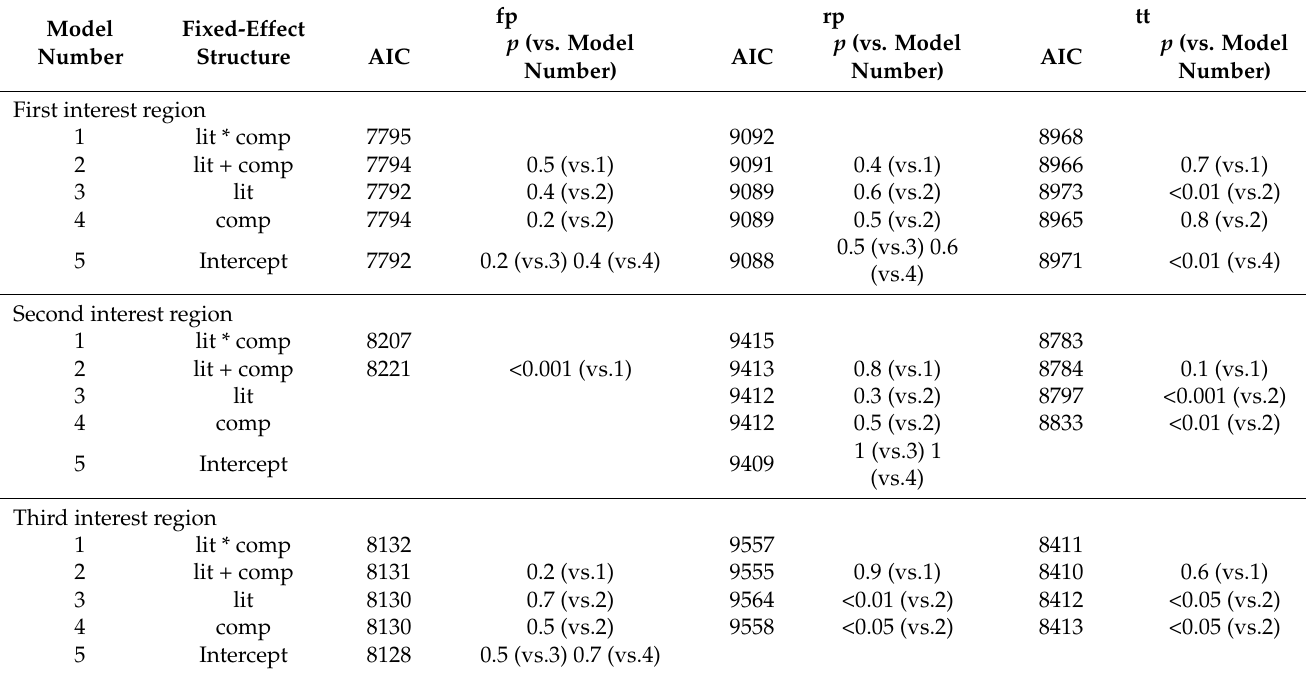
Table 2. Series of likelihood ratio tests, with their AIC and p values.